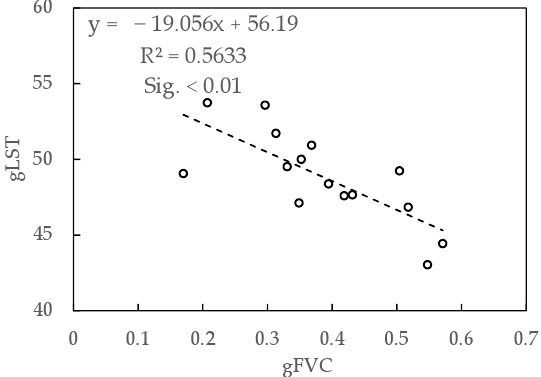
Figure 5. Relationship between gFVC and gLST at 23 July 2020 in field survey experiment.